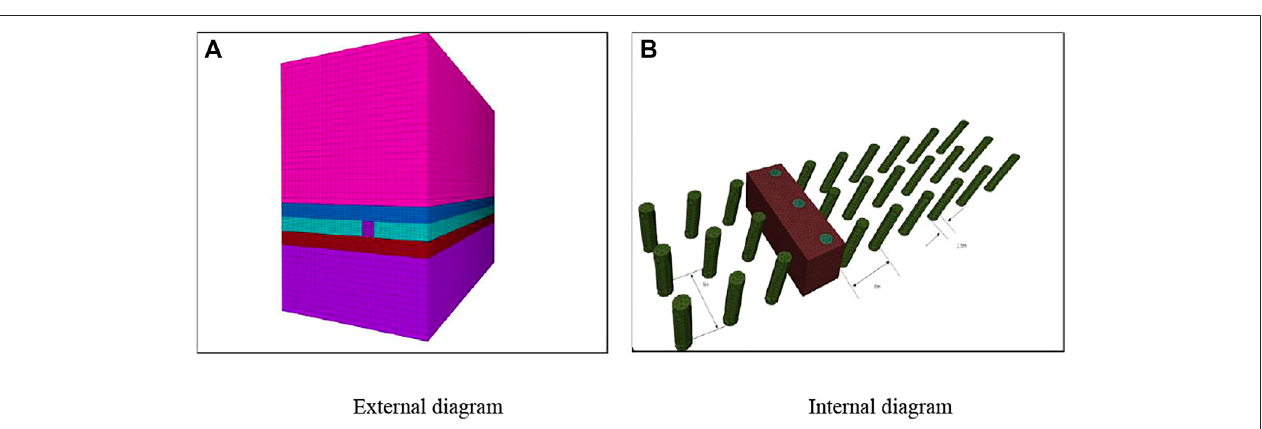
FIGURE 6 | Schematic diagram of the model. (A) External diagram. (B) Internal